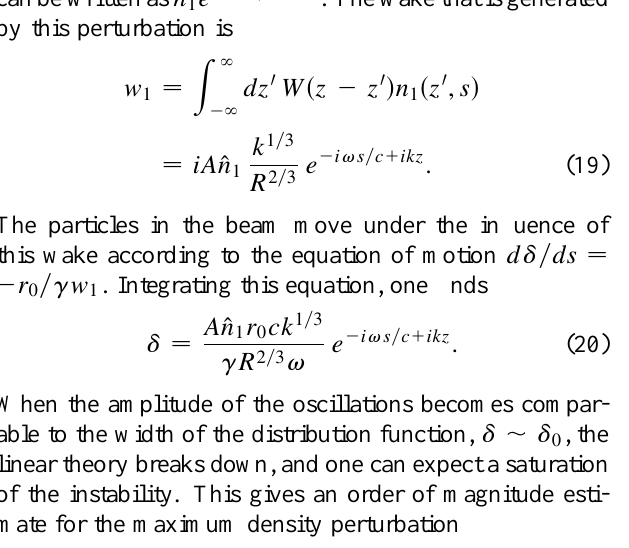
TABLE I. Beam and instability parameters for LER, ALS, and VUV rings.